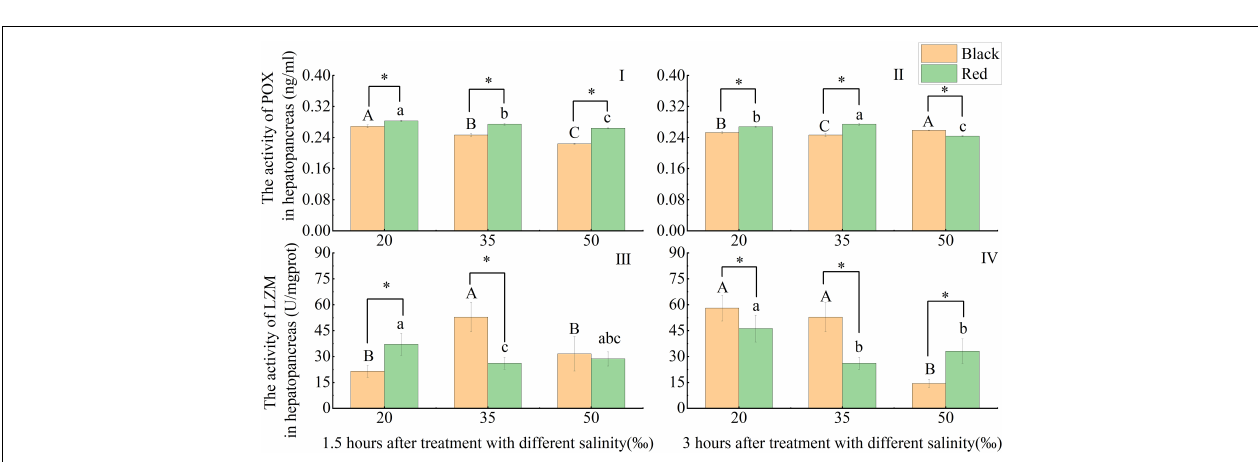
FIGURE 3 | Effect of acute salinity stress on the activities of succinate dehydrogenase (SDH), lactate dehydrogenase (LDH), and Na + -K + -ATPase (NKA) in the gill tissues of black and red shell-colored P. fucata ( I: 1.5 h, SDH activity. II: 3 h, SDH activity. III: 1.5 h, LDH activity. IV: 3 h, LDH activity. V: 1.5 h, NKA activity. VI: 3 h, NKA activity). The asterisk sign “ ∗ ” indicates that there are significant differences between the different shell colors at the same salinity ( p < 0.05).